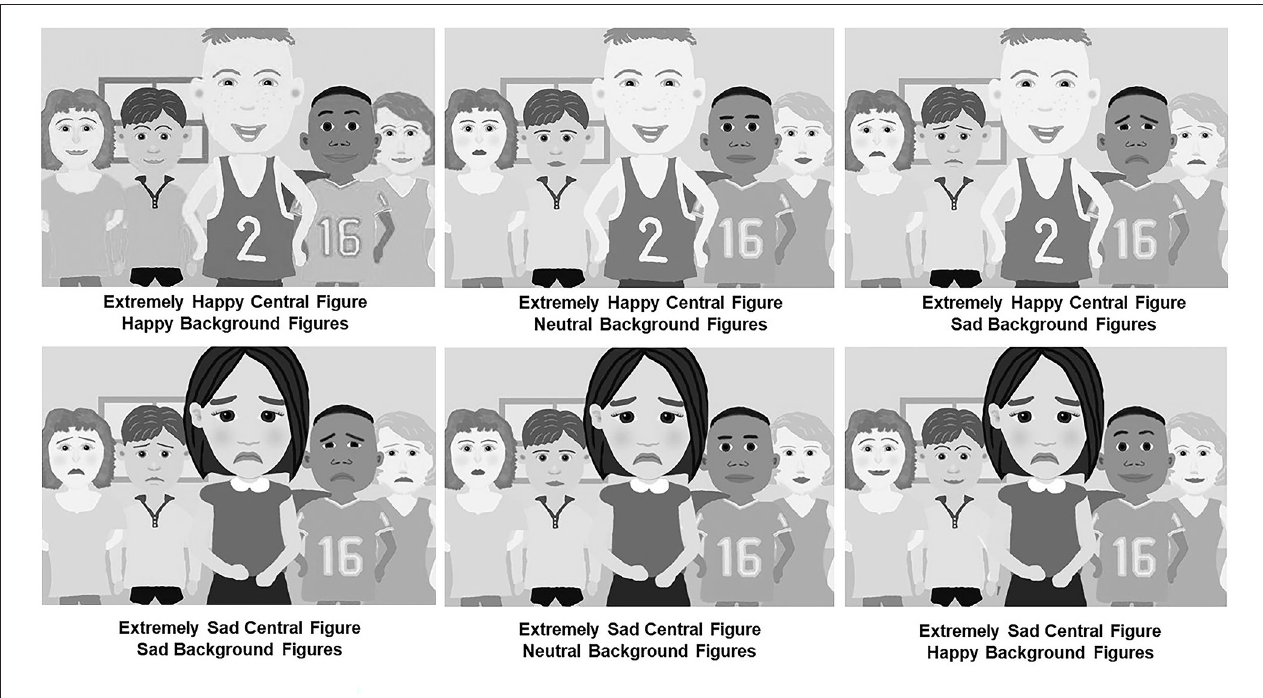
FIGURE 1 | Examples of stimuli used in the study. From left to right the stimuli display a congruent condition then two incongruent conditions,